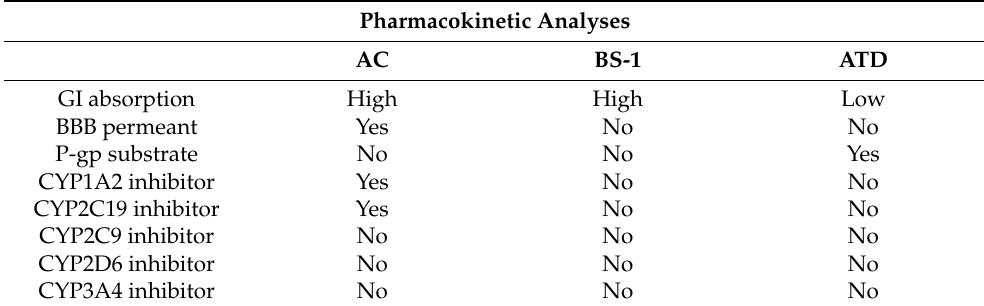
Table 2. Pharmacokinetic analyses of AC, BS-1 and ATD. These analyses were performed with the Swiss ADME server.